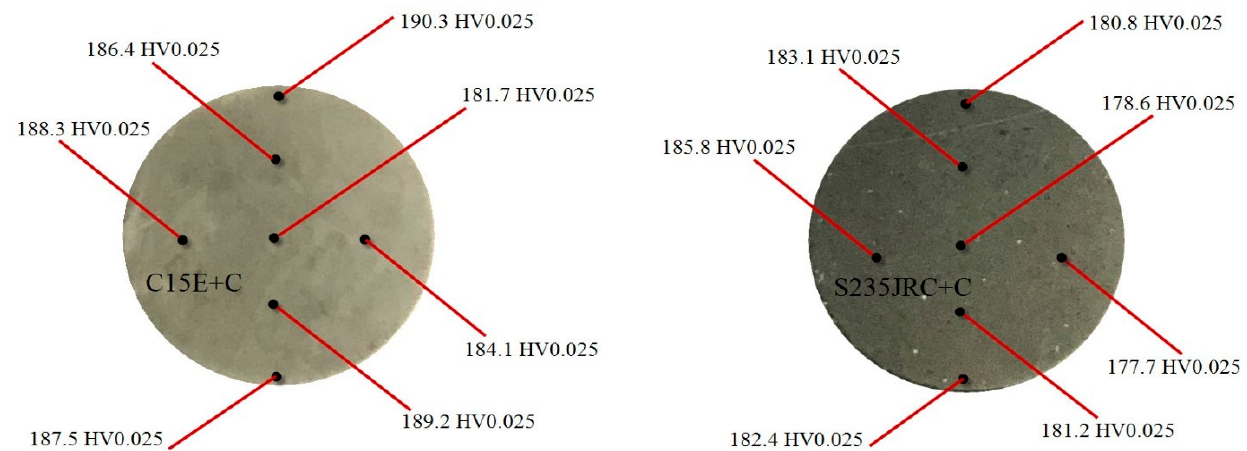
Figure 4. Microhardness test: C15E+C (left) and S235JRC+C (right) steel alloys.